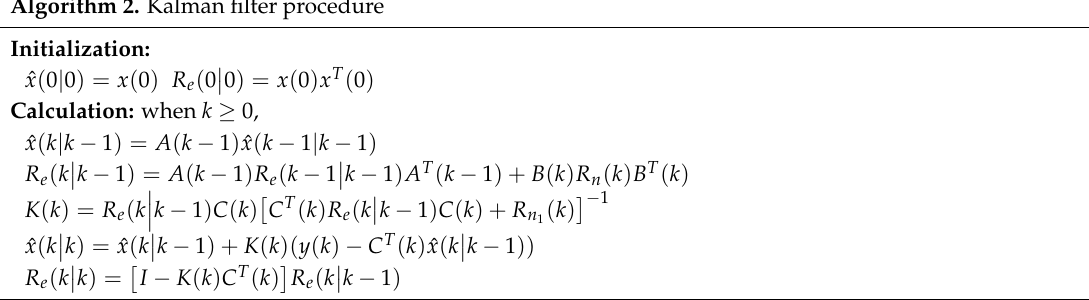
Algorithm 2. Kalman filter